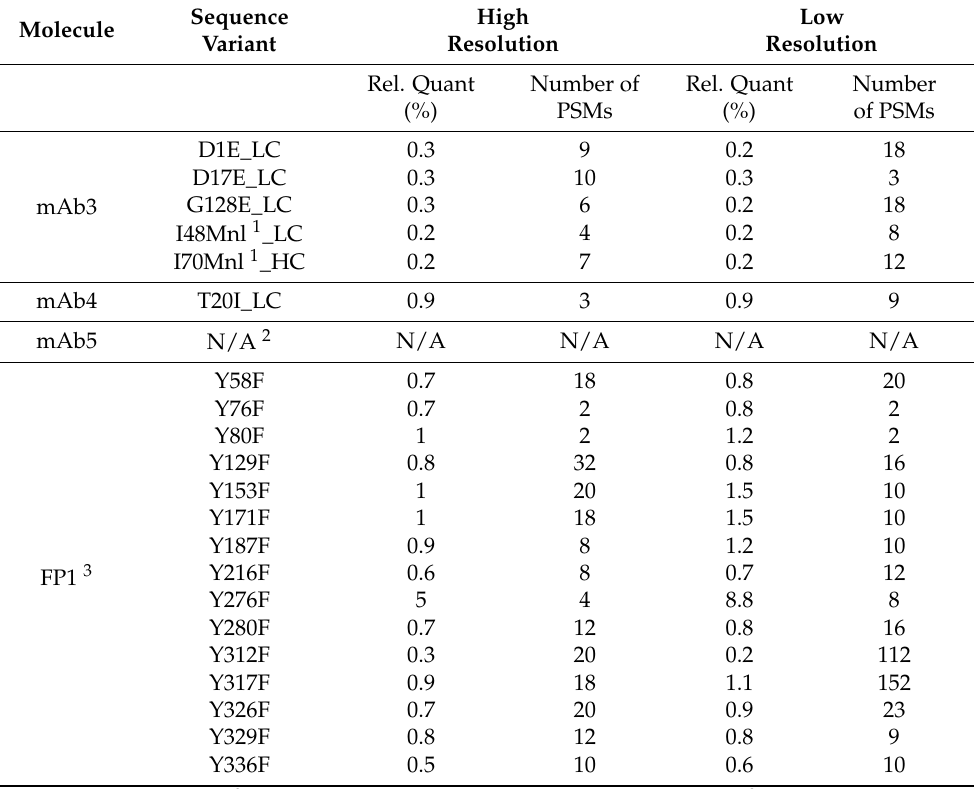
Table 3. High vs. low-resolution SVA method quantitation and PSM comparison. Sequence High Molecule Variant Resolution